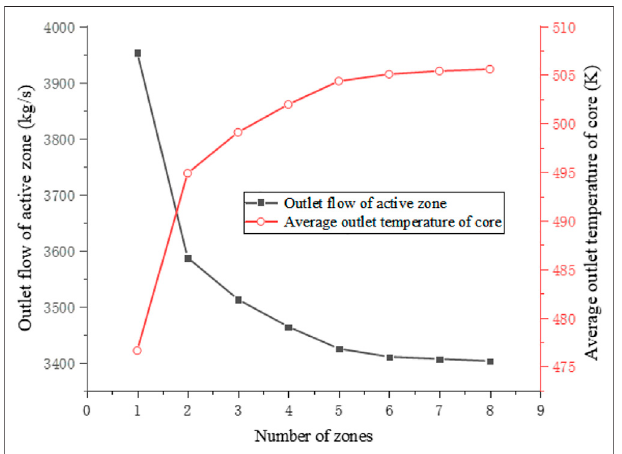
FIGURE 8 | Total active zone fl ow and active zone exit temperature for different number of zones.